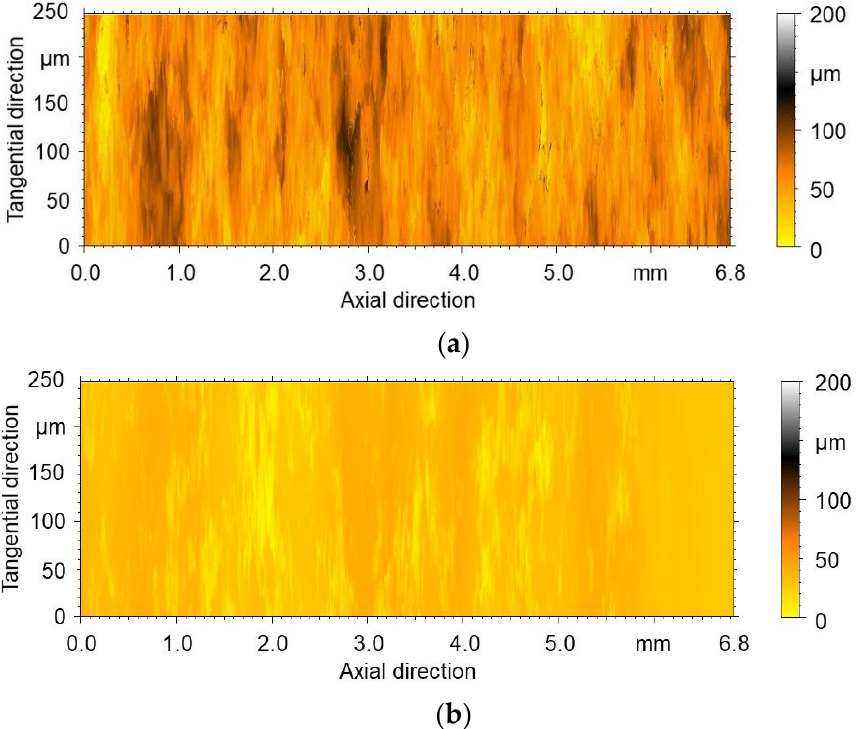
Figure 7. Axial roughness line scans for ( a ) ZnAl-coated (II) and ( b ) MHP post-treated (III) specimens.